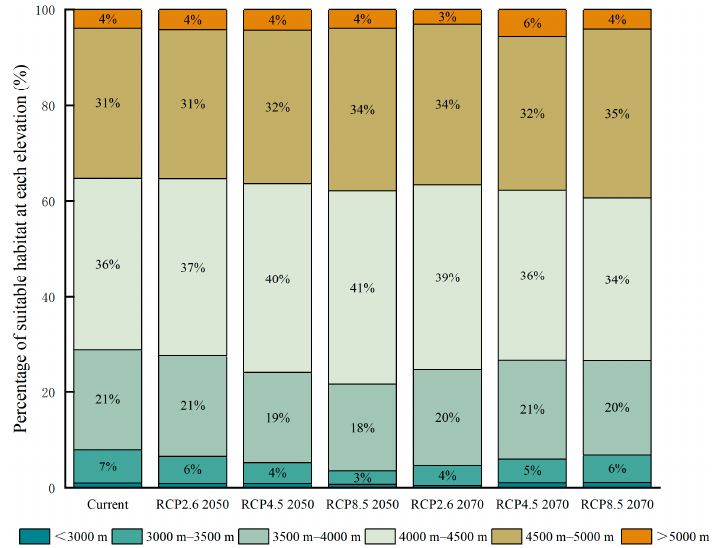
Figure 3. The habitat suitability of Siberian ibex in Taxkorgan Nature Reserve under three green- house gas emissions scenarios for two periods; top panel predictions for 2050 and bottom panels for 2070. ( a ) RCP 2.6 for 2050; ( b ) RCP 4.5 for 2050; ( c ) RCP 8.5 for 2050; ( d ) RCP 2.6 for 2070; ( e ) RCP 4.5 for 2070; ( f ) RCP 8.5 for 2070.